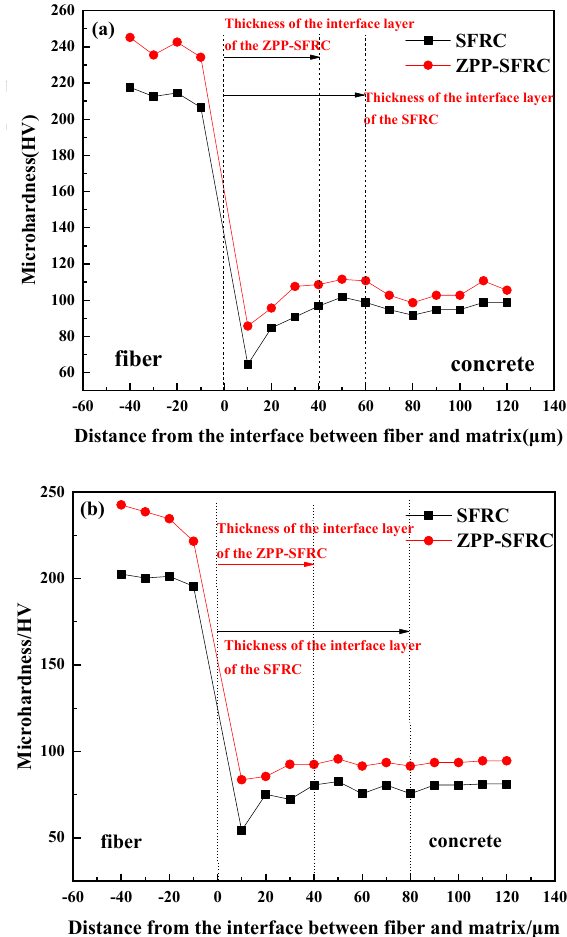
Figure 4. Micro-hardness of the interface layer between ZPP-SFRC (zinc phosphate modified steel fiber reinforced concrete) and SFRC (steel fiber reinforced concrete) under different environments: ( a ) without corrosion and ( b ) with NaCl corrosion.